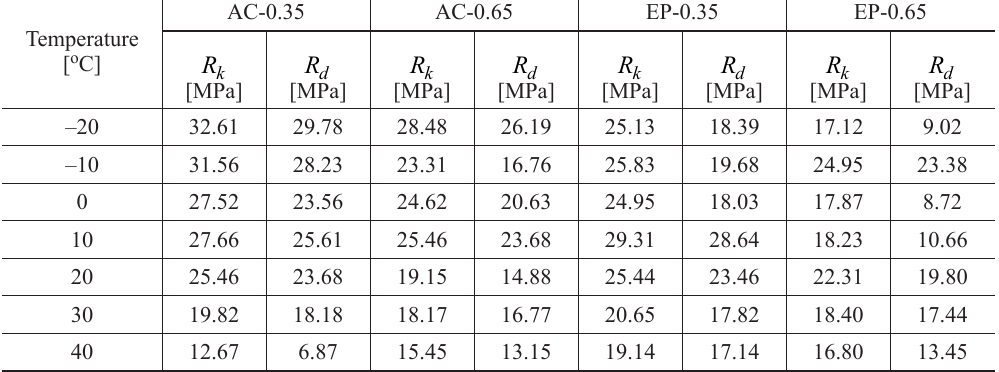
Table 1. Characteristic and design values ,